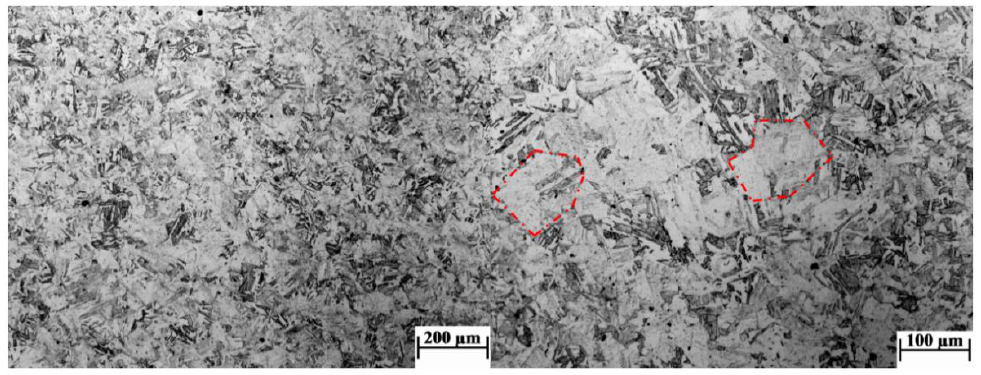
Figure 8. Grain size of three-times heating